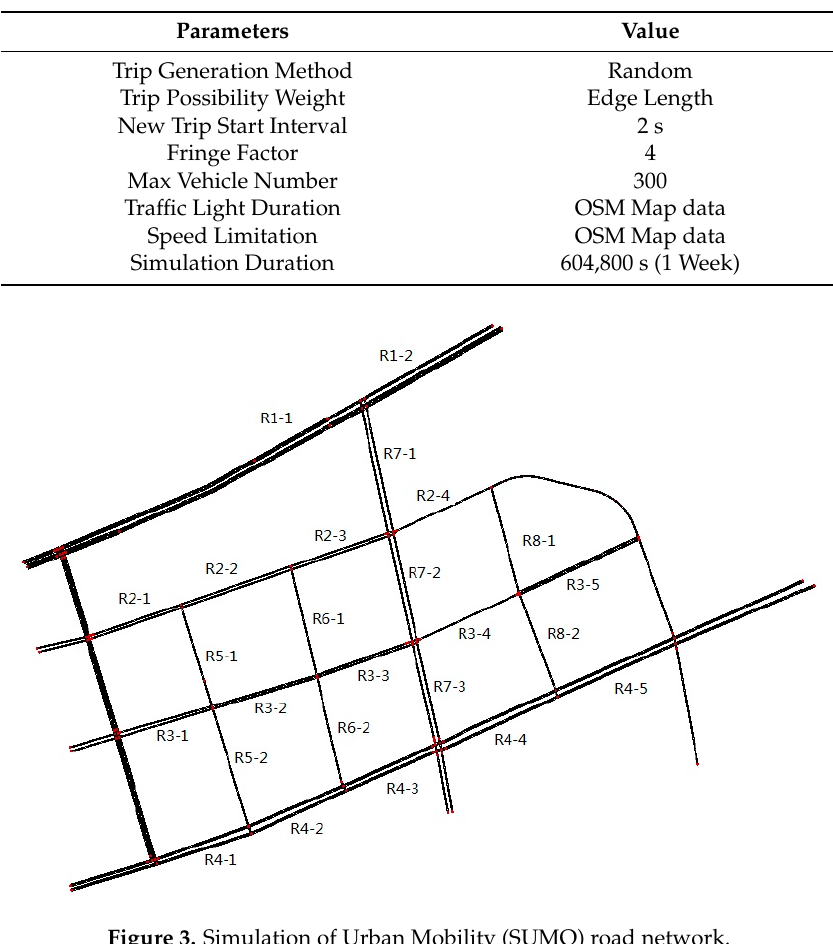
Figure 3. Simulation of Urban Mobility (SUMO) road network.